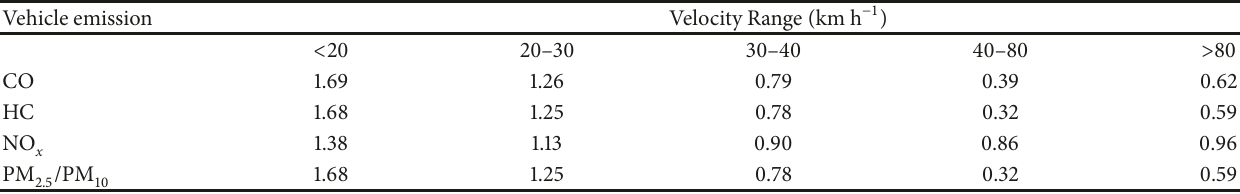
Table 6: Gasoline vehicle average speed correction factor.